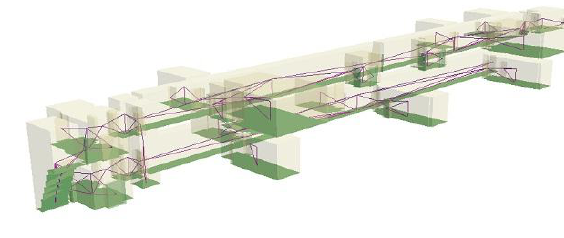
Figure 15. Obstacle (light maroon color) and navigable (green color) space according to walking locomotion type.